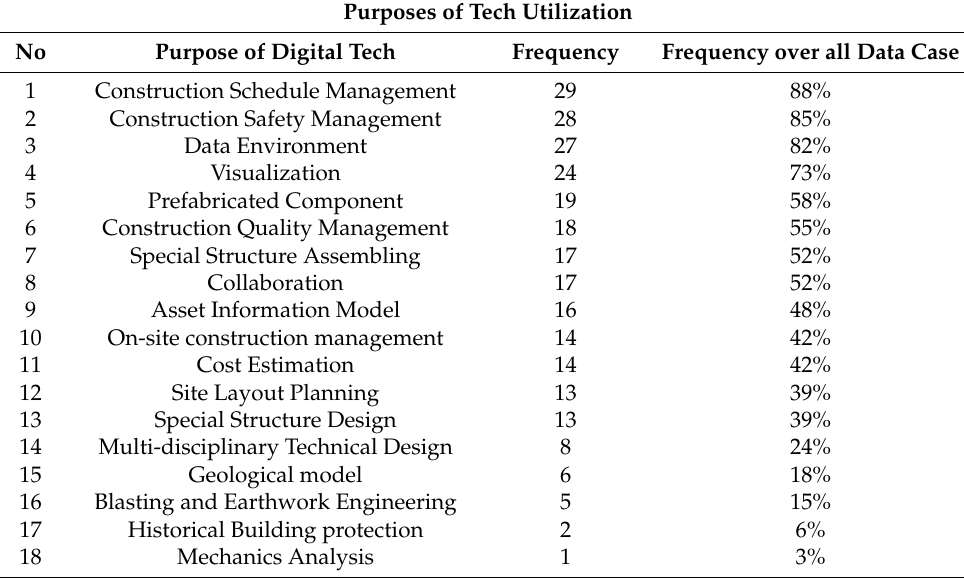
Table 7. Purposes of technology